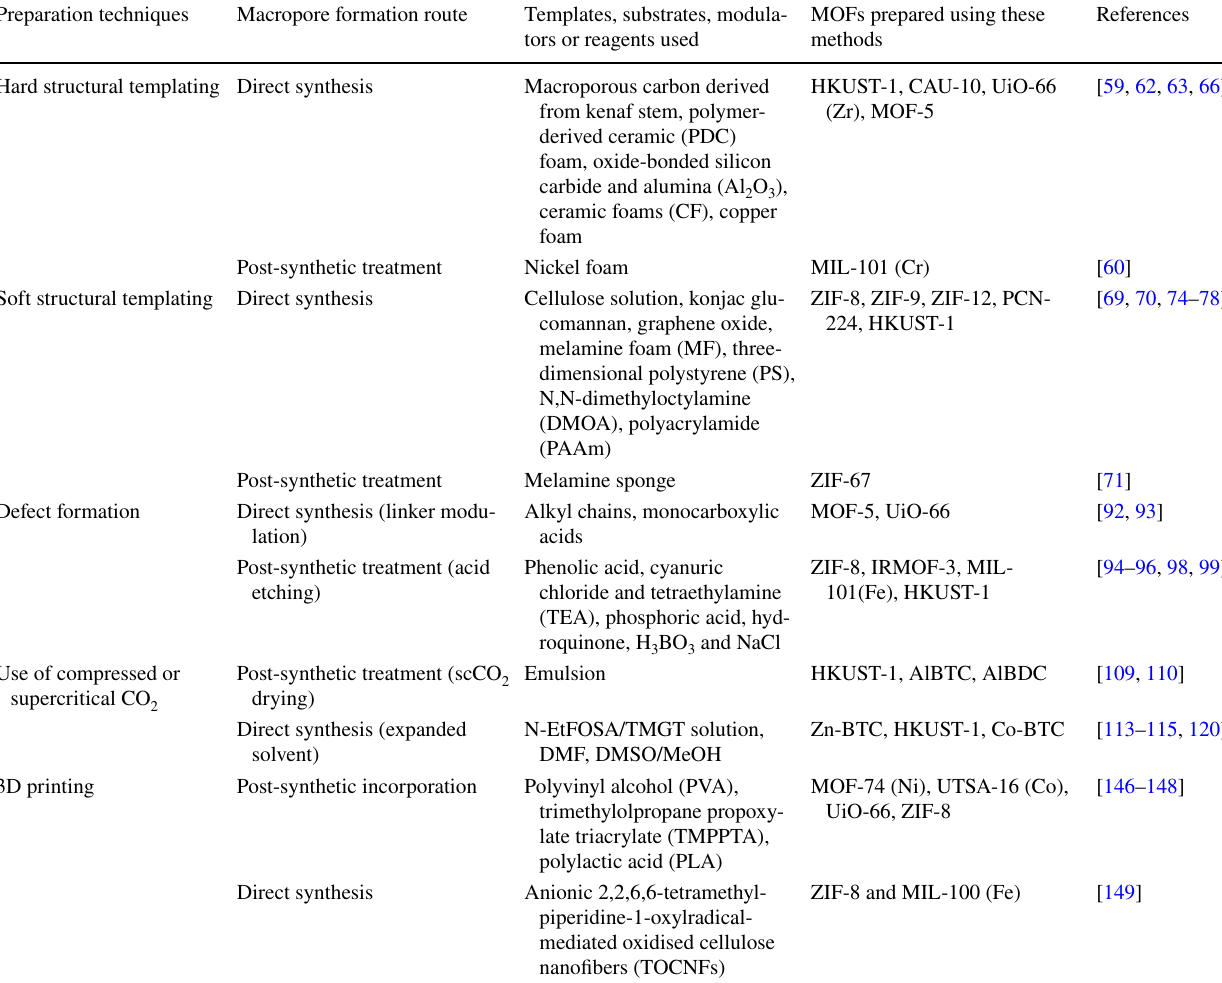
Table 1 A summary of preparation techniques, crystallisation routes, and templates for the formation of hierarchical MOFs with macroporosity Preparation